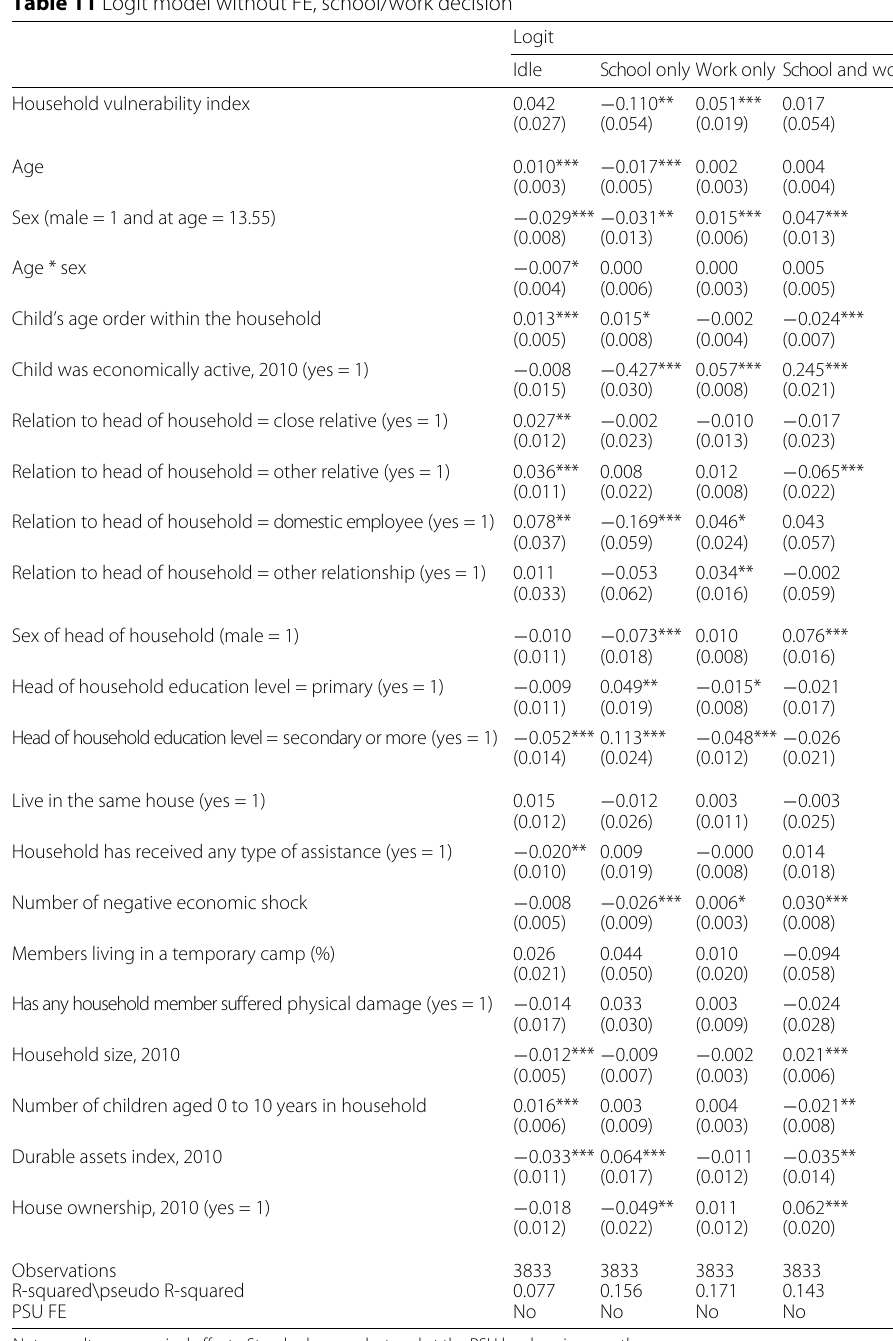
Table 11 Logit model without FE, school/work